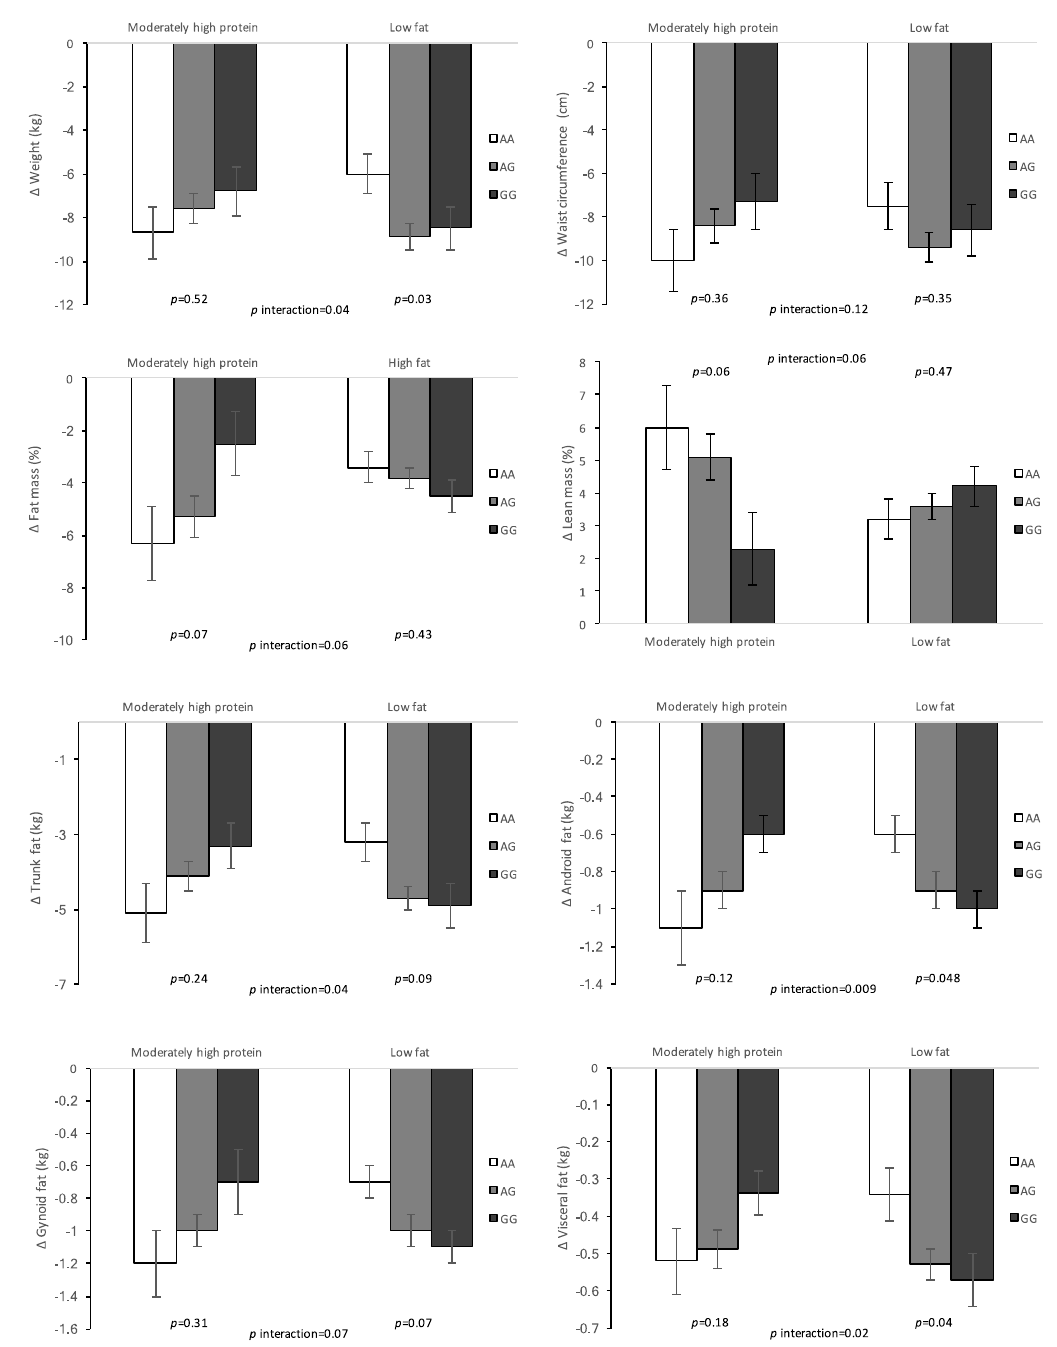
Figure 1. Effect of the ADCY3 rs10182181 genetic variant on changes in body fatness and composition in response to moderately-high-protein/low-fat diet after 16 weeks of diet intervention (co-dominant model).